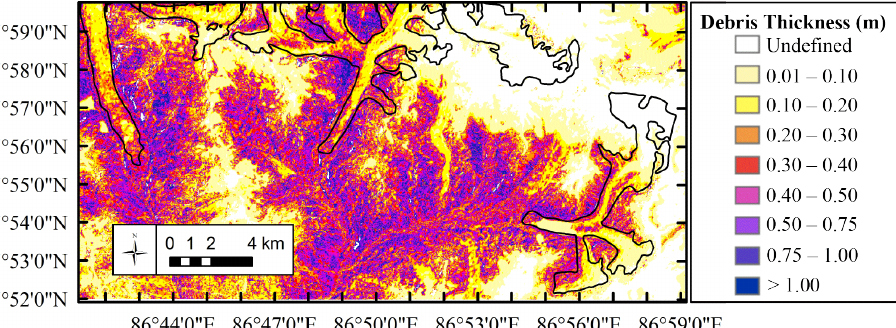
Figure 7. Debris thickness (m) using the ASTER GDEM and nonlinear sloped model for debris-covered glaciers in the Everest region with Ngozumpa, Khumbu, and Imja–Lhotse Shar glaciers, left to right, respectively, outlined using the GLIMS